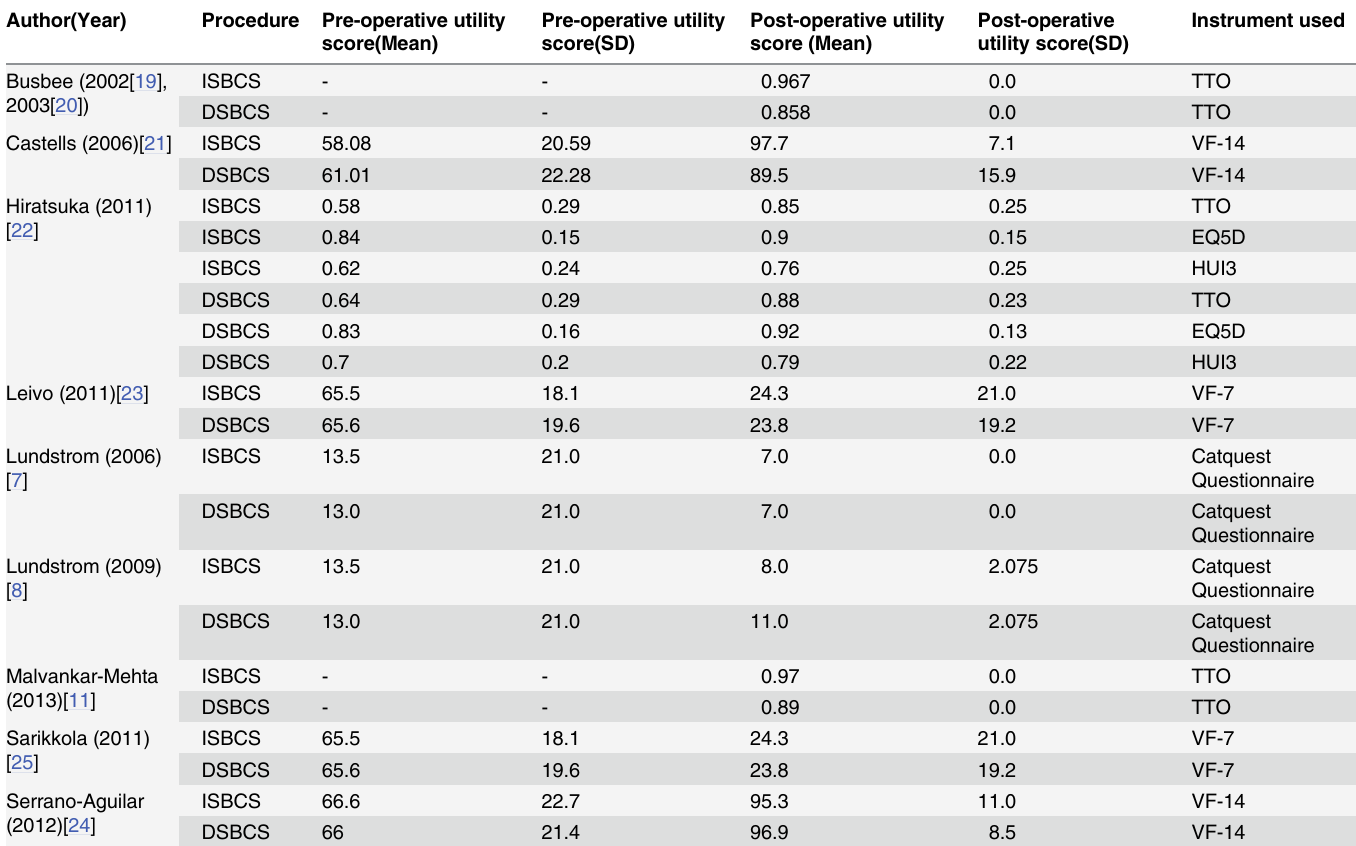
Table 2. Utility Scores Reported in Studies Included in